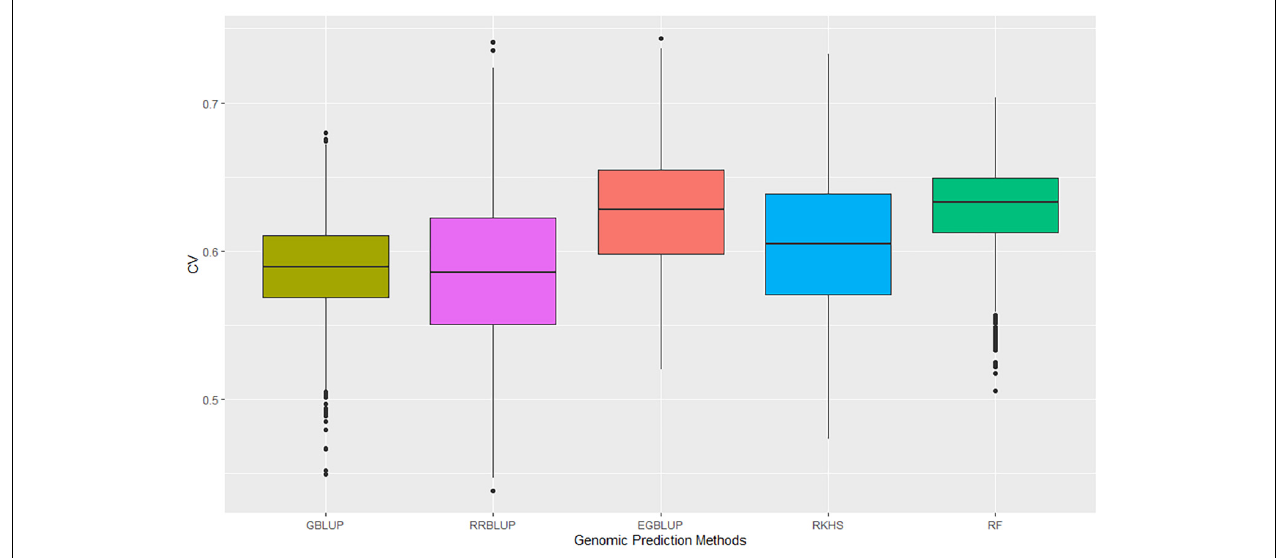
FIGURE 2 | Prediction accuracies of five genomic prediction methods for the G × E data calculated as correlation of GEBVs predicted to phenotypic data of the advanced breeding lines. GEBVs, genomic estimated breeding values.